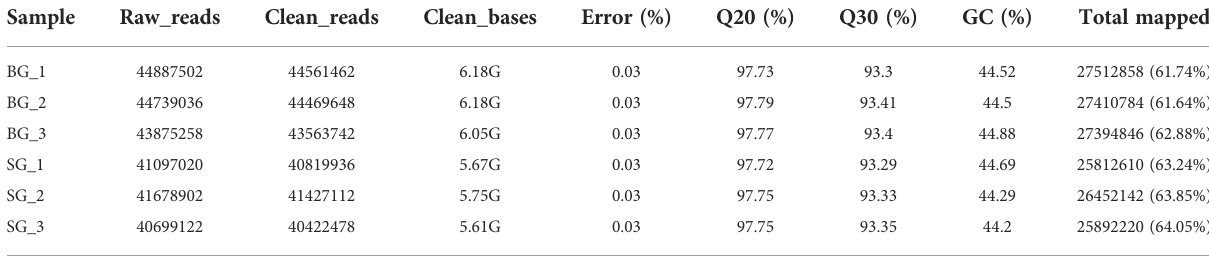
TABLE 1 Data quality of each sample in BG and